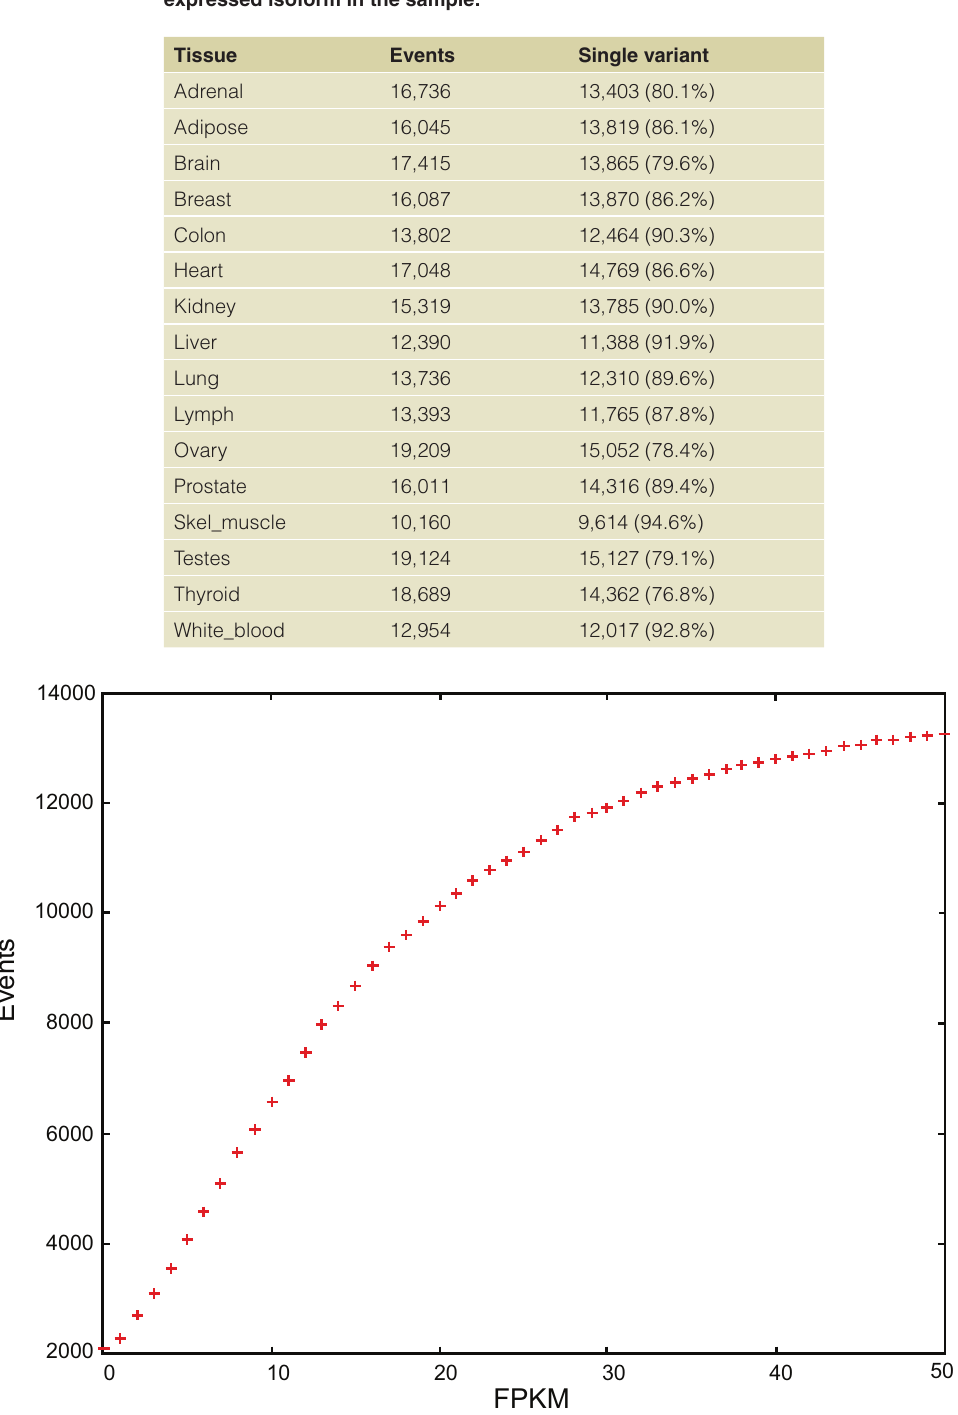
Table S11. Exon skipping events expressed in each tissue sample, and number/percentage of these events that have only one expressed isoform in the sample.